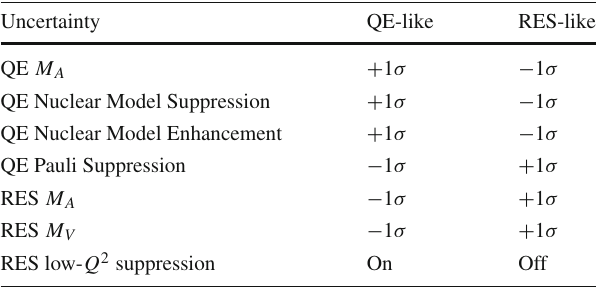
Table 2 Correlated systematic uncertainty shifts used to make the non- 2p2h simulation more “RES-like” or “QE-like” before fitting the 2p2h component Uncertainty QE-like